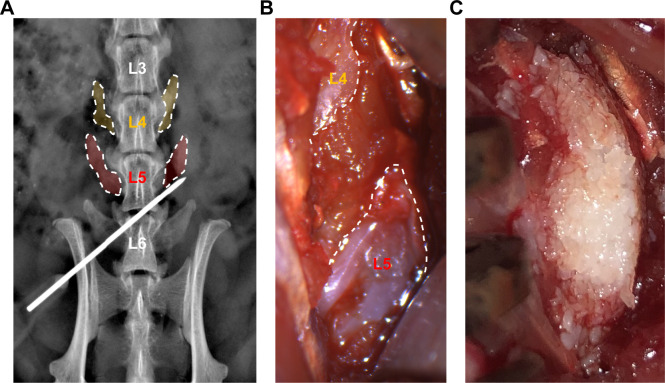
Illustration of procedure for posterolateral lumbar spine fusion in athymic rats.(A) Intraoperative postero-anterior high-resolution x-ray to confirm the bony landmarks. The needle is indicating the base of L5 right transverse process. (B) Intraoperative microsurgical image of the right paraspinal space after decortication of L5 transverse process. (C) Appropriate place and shape of the bone graft substitute in the area encompassing the L4-L5 transverse processes. See Supplementary file 6 for animal allocation.